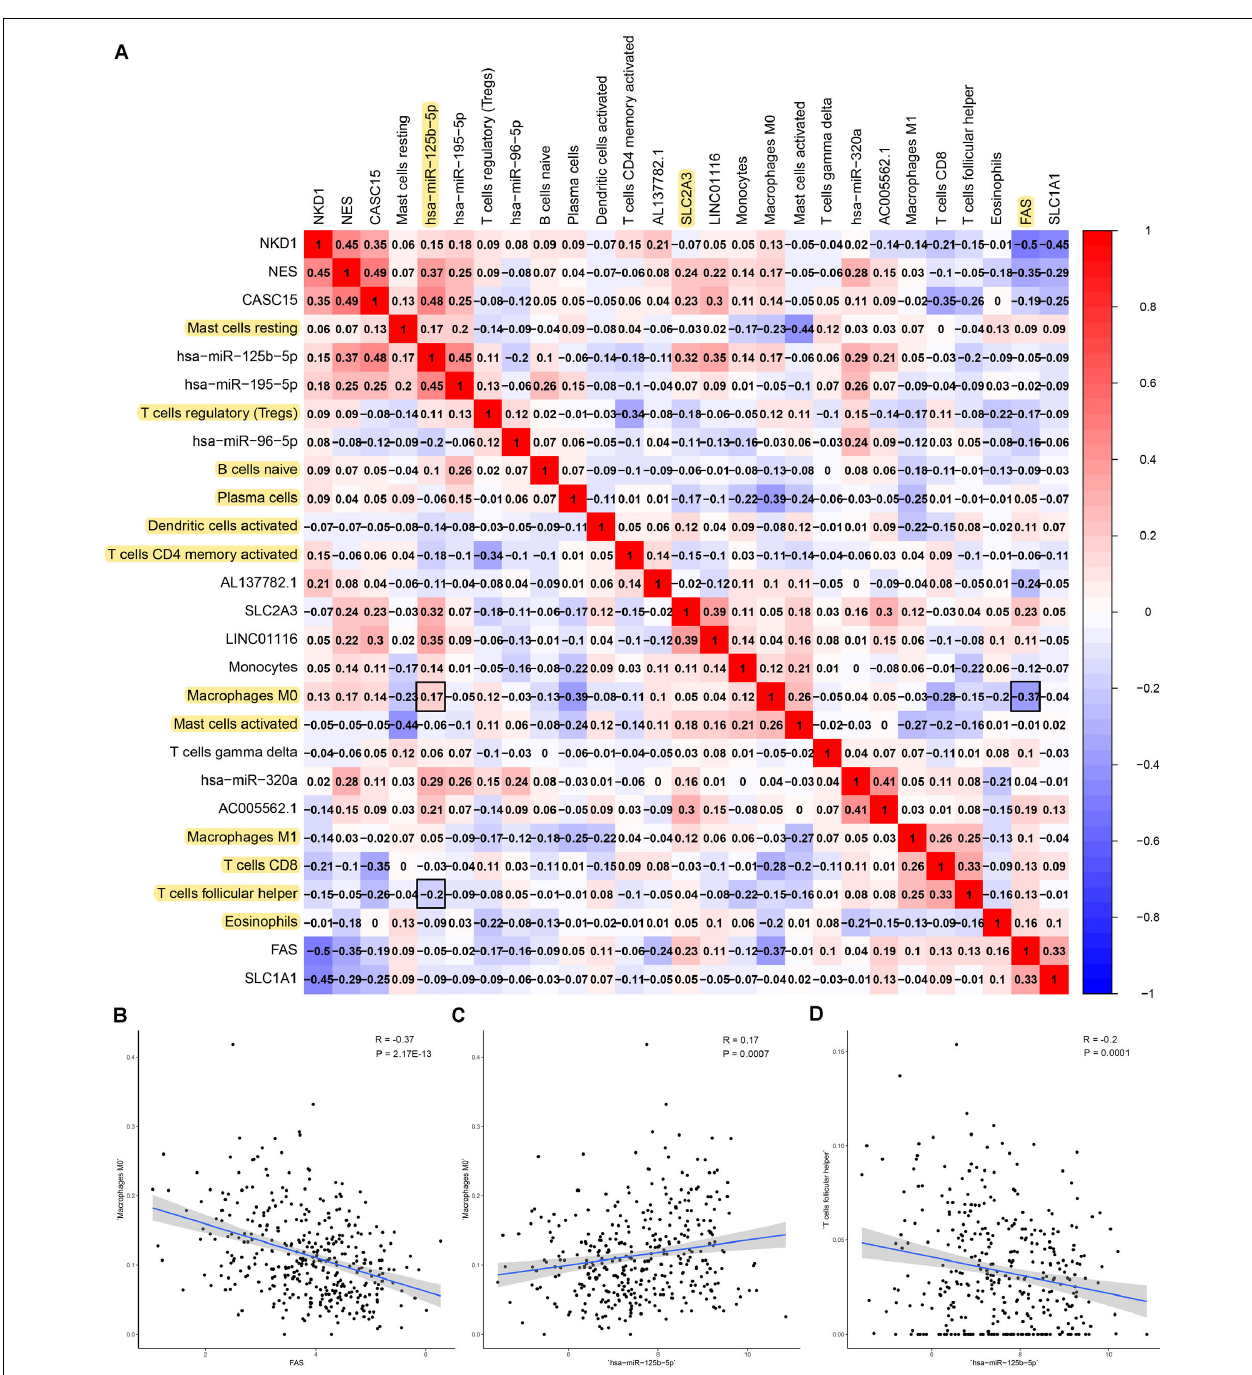
FIGURE 8 | The result of the co-expression analysis between tumor-infiltrating immune cells and key members of ceRNA network. The co-expression heatmap illustrated some significant co-expression patterns about key members in the ceRNA network and key members in the immune cells (A) . T cells follicular helper and hsa-miR-125b-5p ( R = − 0.200, P < 0.001) Macrophages M0 and hsa-miR-125b-5p ( R = 0.170, P < 0.001) and Macrophages M0 and FAS ( R = − 0.370, P < 0.001) and these could describe the significant relationship between the key biomarkers and distance metastasis COAD (B–D) .